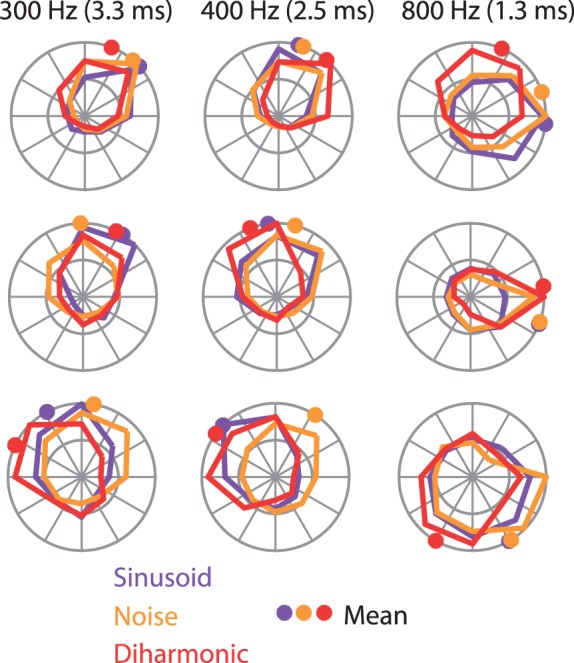
Phase tuning for complex stimuli.Normalized histograms showing phase tuning for sinusoidal (purple), diharmonic (red), and band-pass noise stimuli (orange) at three different frequencies (indicated at the top, along with the corresponding cycle duration) for three example neurons (rows). Colored dots indicate preferred phase. The phase tuning is highly consistent across stimulus types.